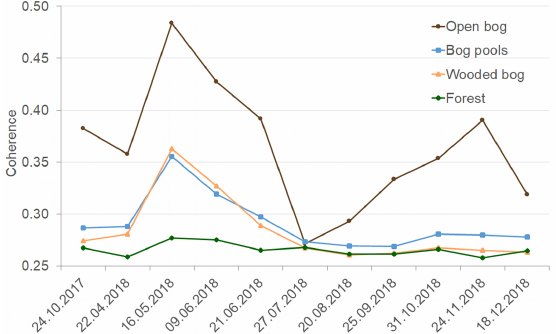
Figure 4. Long term seasonal InSAR coherence by different natural land cover classes. Seasonal recovery of coherence is characteristic only to the open bog. Other land cover classes associated with bog (wooded bog and bog pools) display no or only marginal signs of